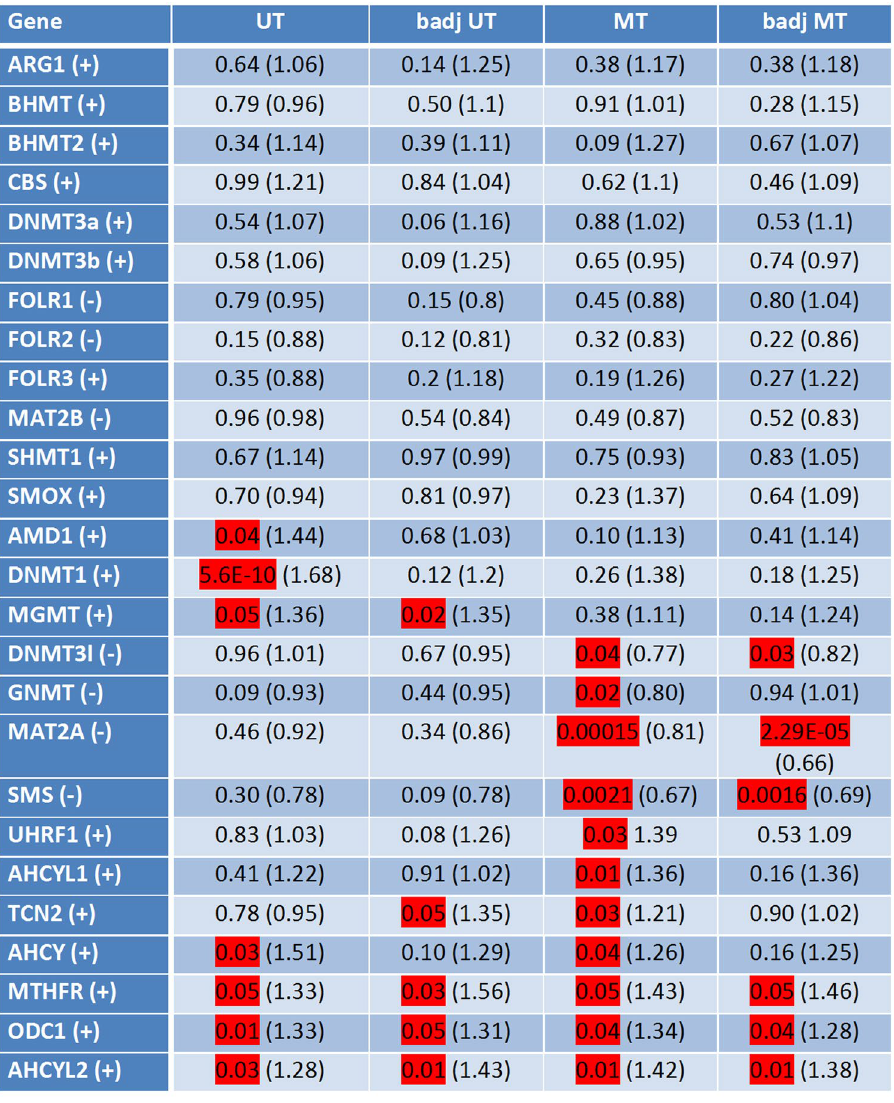
Figure 1. Differences in methylation in 5 ′ regulatory regions of key methyl group metabolism genes in urothelial carcinoma. Differentially methylated regions (DMRs) were detected by MeDIP/promoter array analyses applied on 4 reference specimens of healthy urothelium, compared to 10 UC tissue specimens from unifocal tumors (UT), 4 specimens adjacent to a unifocal tumor, histologically verified as benign, normal urothelial tissue (badj UT), 5 UC tissue specimens from multifocal tumors (MT) and 5 specimens adjacent to a multifocal tumor, histologically verified as benign, normal urothelial tissue (badj MT). Statistical significance of the detected differential methylation in the tumors and tumor adjacent tissue groups was evaluated using the two sample Student’s t-test. The table lists p-values and fold-changes in parentheses. Values of significant occurrence are highlighted in red. “ + ” stands for hypermethylation and “ − ” represents hypomethylation of the respective gene’s